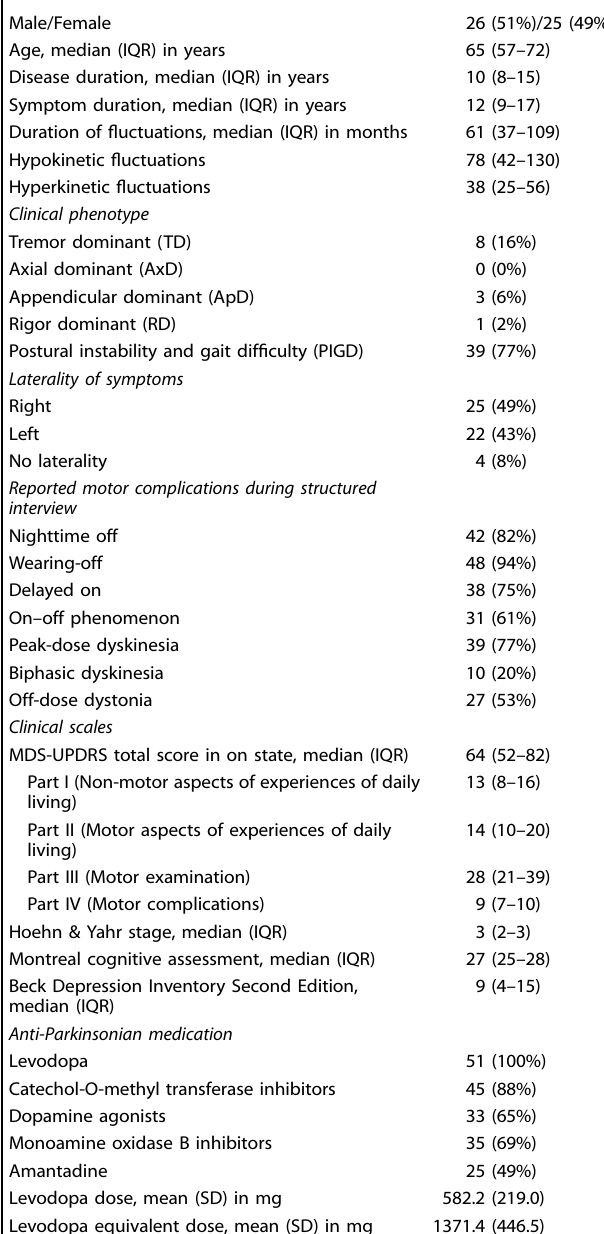
In comparison to the observer, patients documented signi fi - cantly more On without dyskinesia (52.3% vs. 38.9%, P < 0.001) and less On with dyskinesia (21.5% vs. 34.2%, P < 0.001), whereas proportions for Off intervals were not different between the patient and the observer diary (26.2% vs. 27.0%, P = 0.97; Fig. 1a). Corresponding differences were found when we calculated the absolute times spent in individual motor states with respect to diary entries during the observation period (Fig. 1b). Patients reported more On time without dyskinesia (5.4 h vs. 4.0 h,